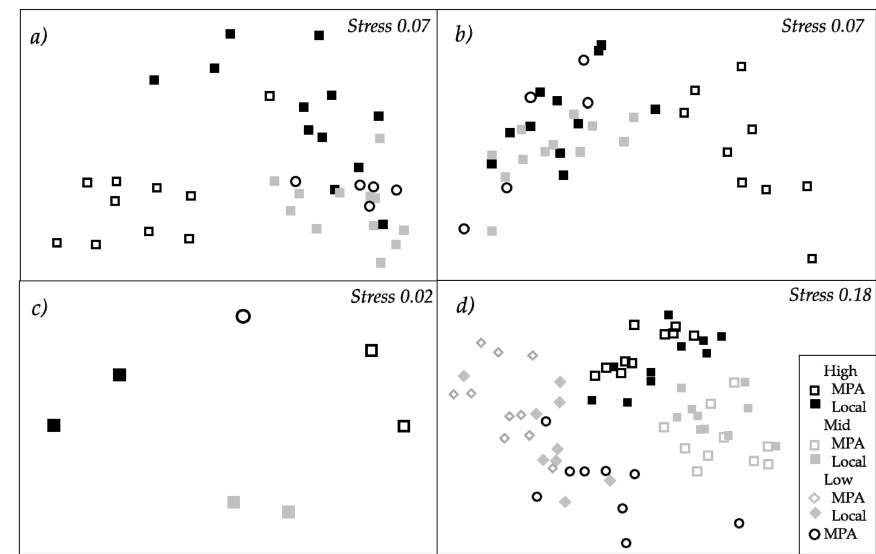
Figure 2. Non-metric multidimensional scaling (nMDS) representing the structure of biofilm assemblages (cyanobacteria, chlorophyll a and diatoms measured with BenthoTorch) among “Pressure” levels after ( a ) 15 and ( b ) 30 days of deployment; ( c ) the structure of bacterial assemblages according to di ff erent “Pressure” levels after 30 days of deployment; ( d ) the structure of macrofouling assemblages after 15 weeks of deployment. All nMDS are based on Bray–Curtis similarities. Data were fourth-root transformed in (c) and square-root transformed in (d) (for further details, see Table 1, Table 2 and Table 5). Table 2. Multivariate analyses of variance of (a) bacteria and (c) diatom assemblages across “Pressure” levels (Pr) after 30 days of panel deployment. Univariate (b) analysis of variance of bacteria assemblage